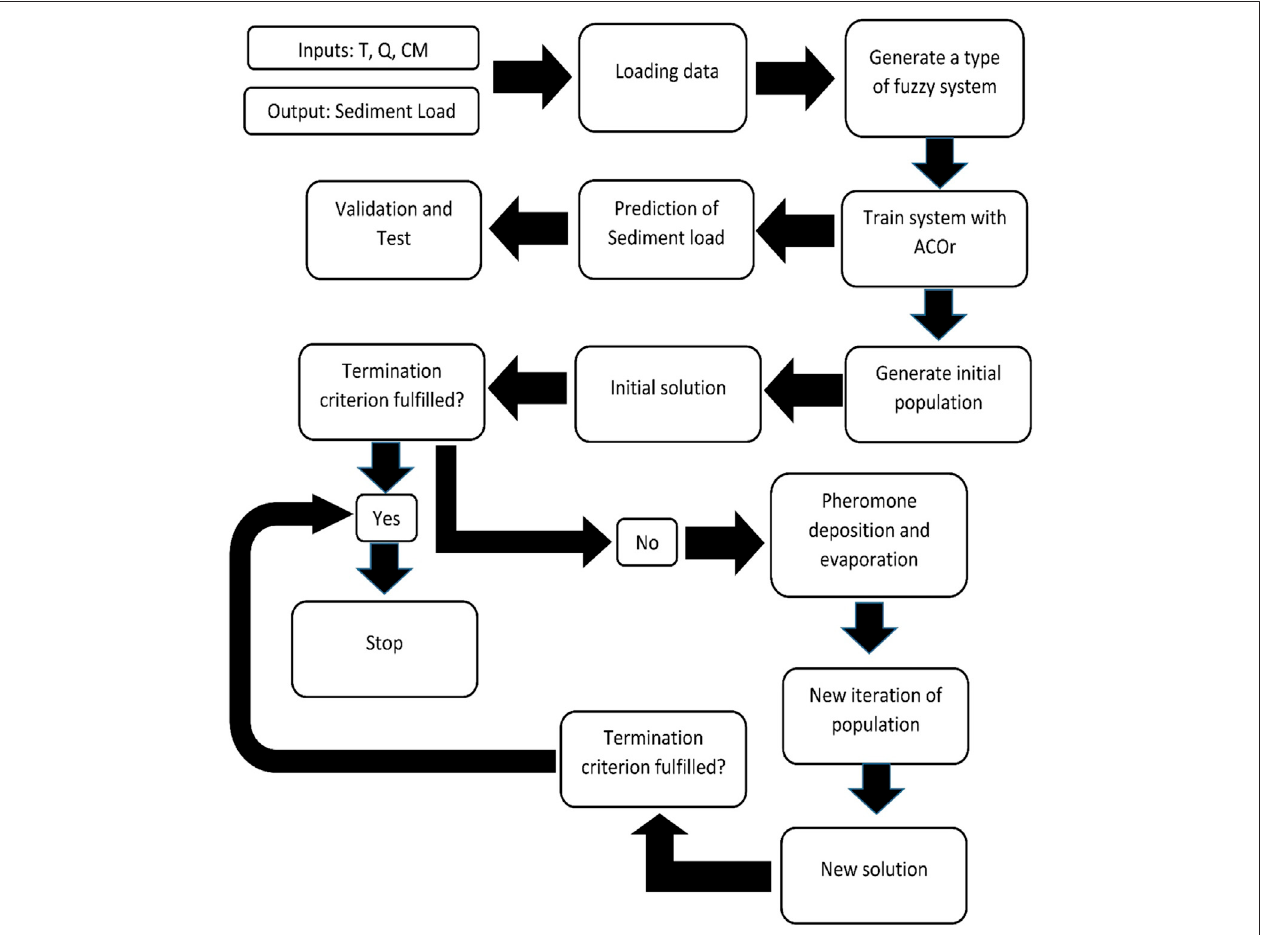
FIGURE 2 | Steps of using ACOr to train